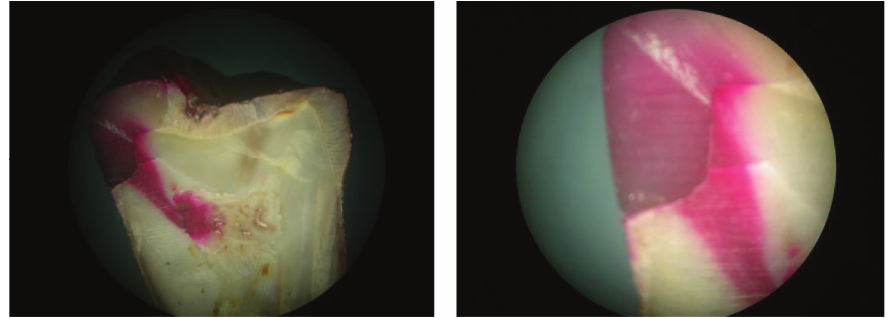
Figure 4: Group 1: microleakage seen under composite restorations without any liner.